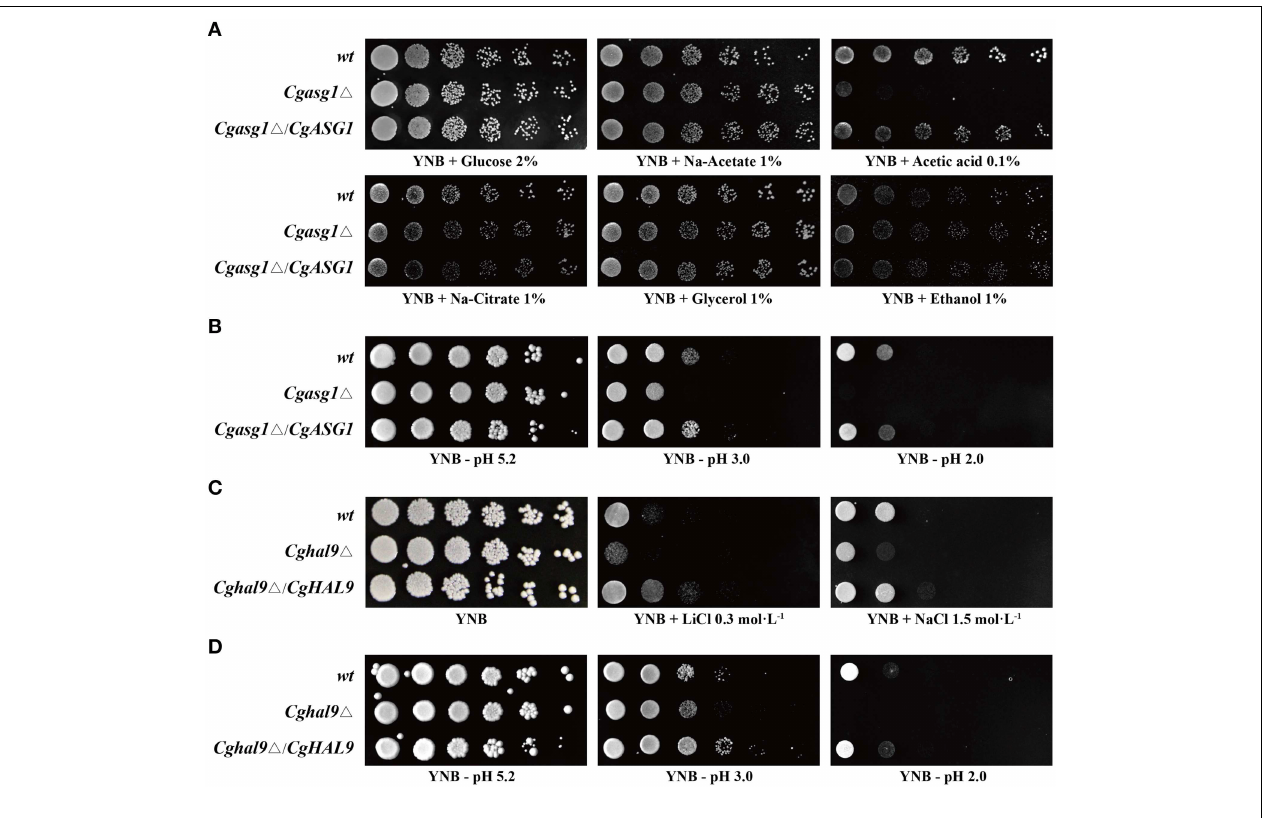
plays a role under acid-stress conditions. Logarithmic-phase cells of each C. glabrata strain were adjusted to 2 × 10 7 cells/mL, and then 4 µ L of serial tenfold dilutions were spotted onto the corresponding YNB media, as indicated. Pictures were taken after 4 days of growth at 30 ◦